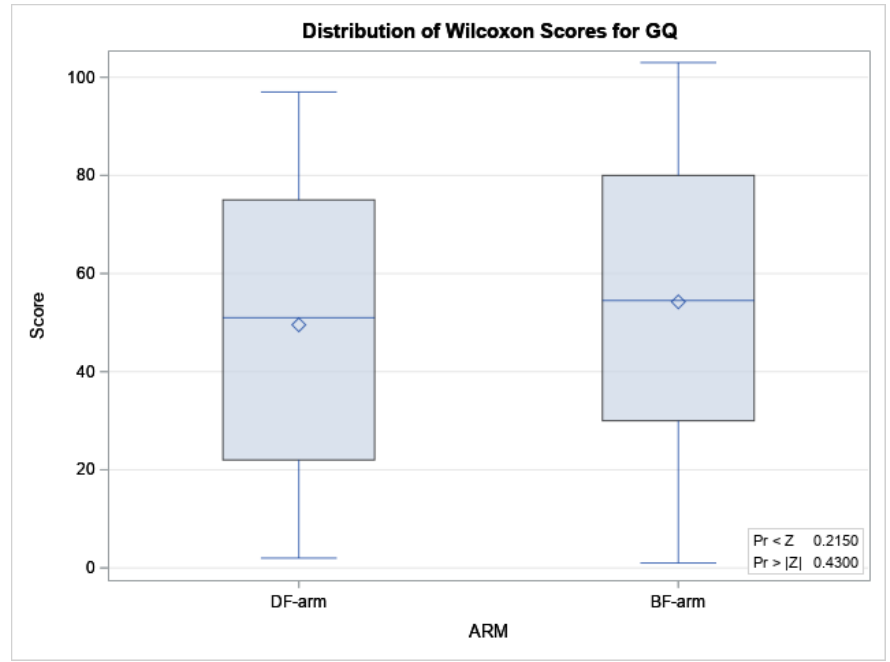
Figure 1. Box plot of Wilcoxon score by arm.